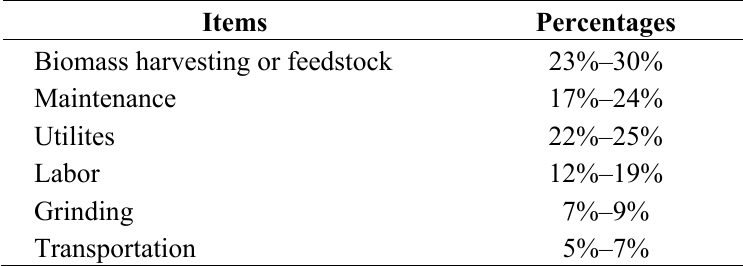
Table 10. Variable cost for a pyrolysis plant